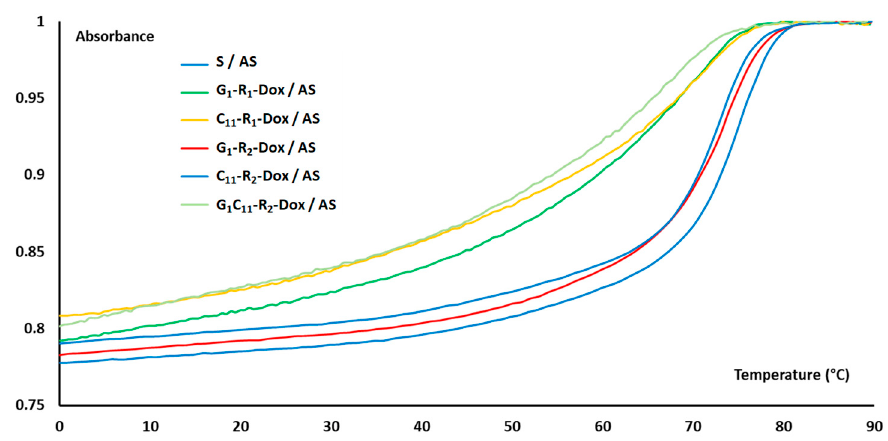
Figure 3. Melting curves of Dox-siRNA duplexes formed between Dox-RNA conjugates and their complementary unmodified RNA antisense ( AS ) strand.